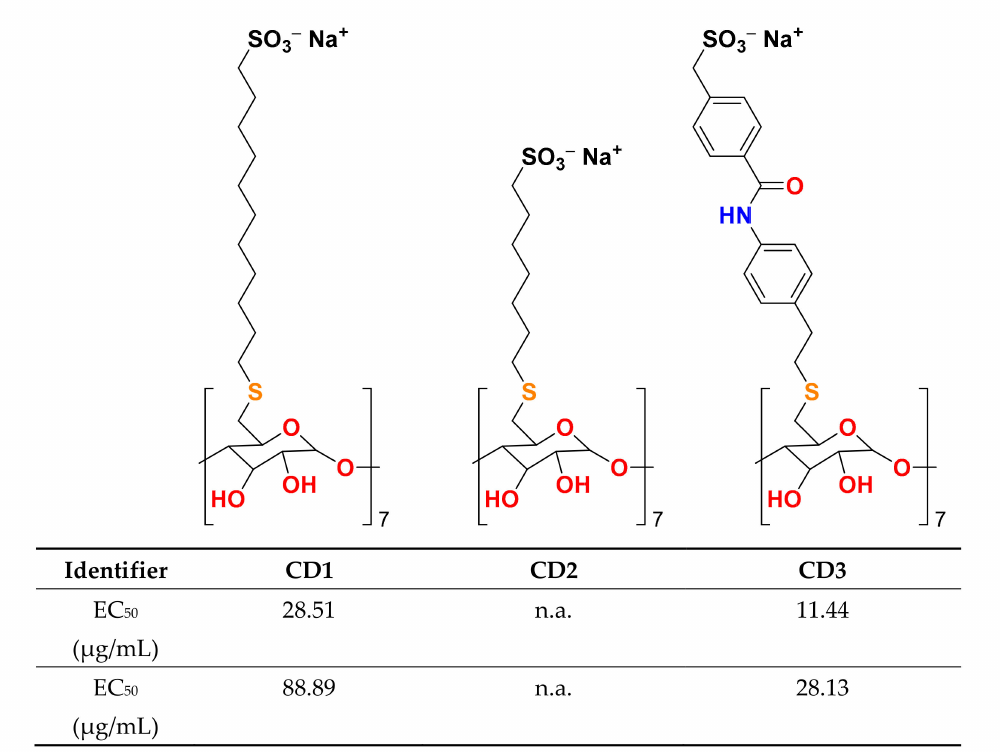
Figure 2. Structure of the modified